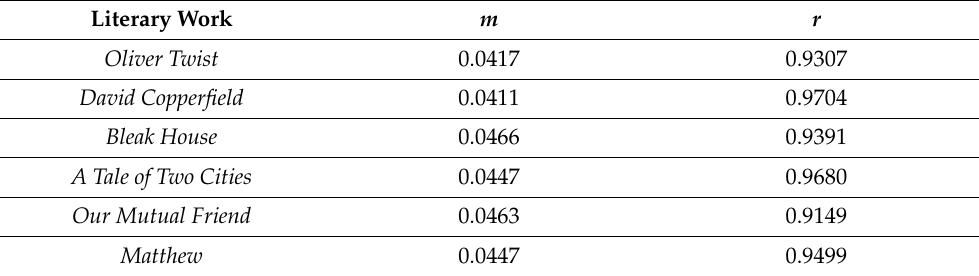
Table 4. Slope m and correlation coefficient r of the regression line between the number of sentences n S (dependent variable) and the number of words n W (independent variable). Four decimal digits are reported because some values differ only from the third